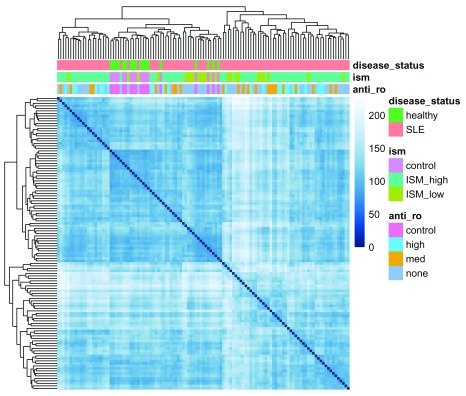
Heatmap showing Euclidean distances between samples clustered using complete linkage. Disease status and other experimental factors are visualised as column annotations.